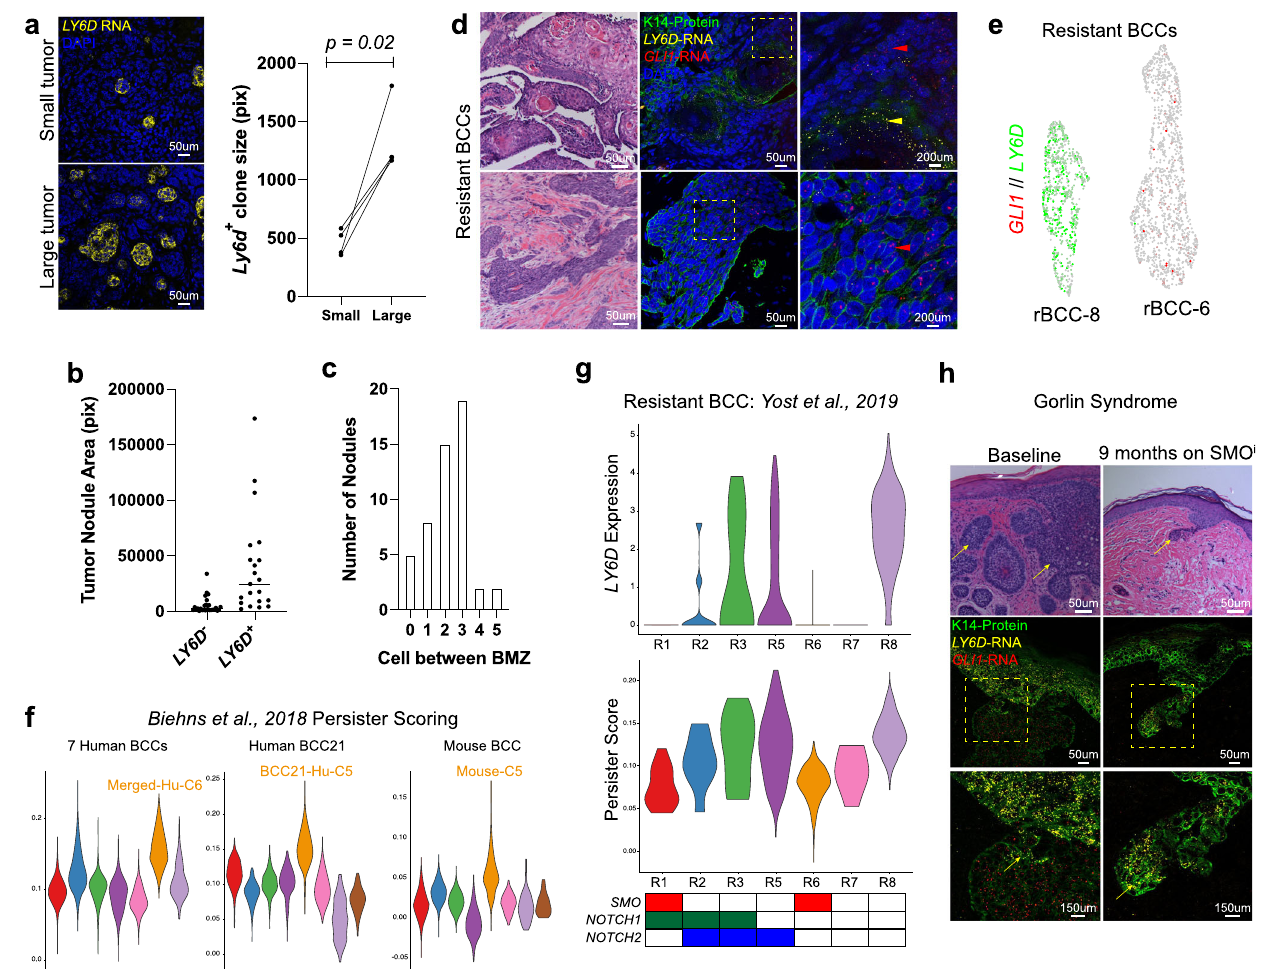
Fig. 4 | Physical features and genetics in fl uence SMO i Resistant LY6D + cellular accumulation. a RNAScope and quanti fi cation of Ly6d + (yellow) clone size from small or large tumors from the same mouse. Each point represents the average clonesizefromsmalland largetumorsfrom thesameprimarymouse ( n =4).Lines between dots indicate the small and large tumors from the same primary tumor. b Tumor nodule areas from human BCC21 that are either LY6D + or LY6D − from Fig.1l.Themedianareaisindicated. c Thenumberof cellsbetweenbasosquamous regions and the BMZ from human BCC21 in Fig. 1l. d H/E and corresponding RNAScope of the spatial localization of LY6D (yellow) and GLI1 (red) in resistant humanBCCs,whichisco-stainedforK14protein(green).Theuppertumordisplays an example of an rBCC with basosquamous/SCC-like features, while the lower tumor does not. Zoomed-in regions are indicated with yellow dashed boxes. Regions enriched for LY6D are indicated with a yellow arrow. Regions enriched for GLI1 are indicated with a red arrow. n =2. e Feature plot of two resistant human